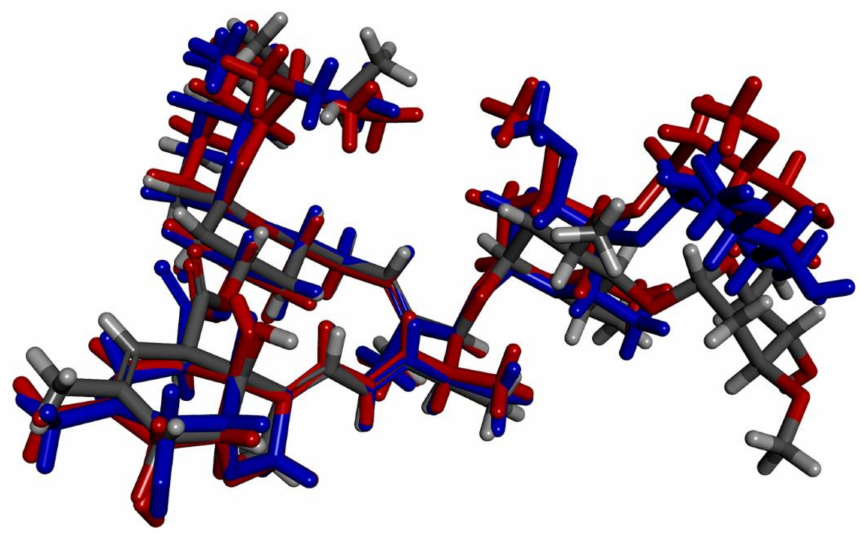
Figure 7. Overlay of IVM molecules present in crystal I (colored by elements, representing conformation in monoclinic structures; overlay of conformation in I and BIFYOF is given in Figure S1, Supplementary Materials) and crystal II (blue and red, representing conformation in orthorhombic structures, overlays of conformations in II and III are given in Figures S2 and S3, (Supplementary